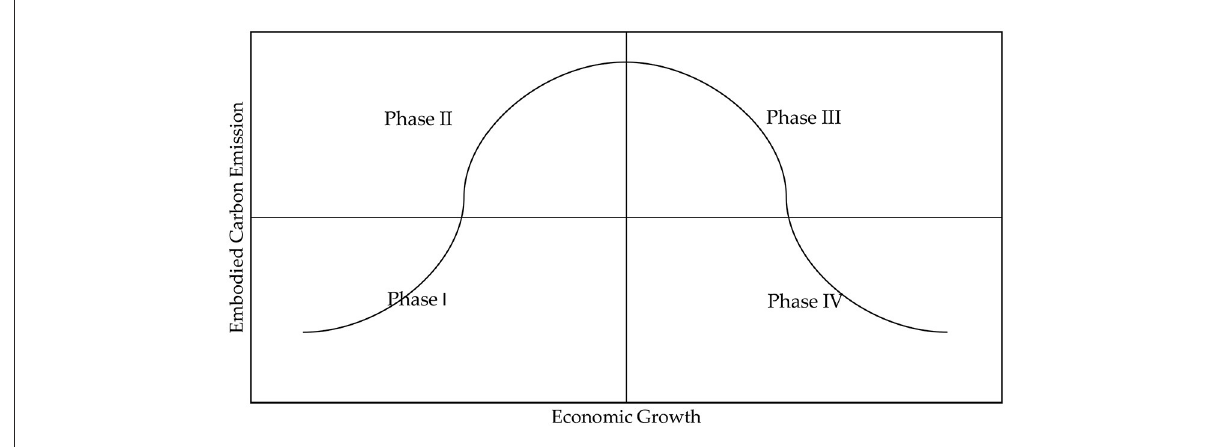
FIGURE2 Economic growth and embodied carbon emission quadrant chart.